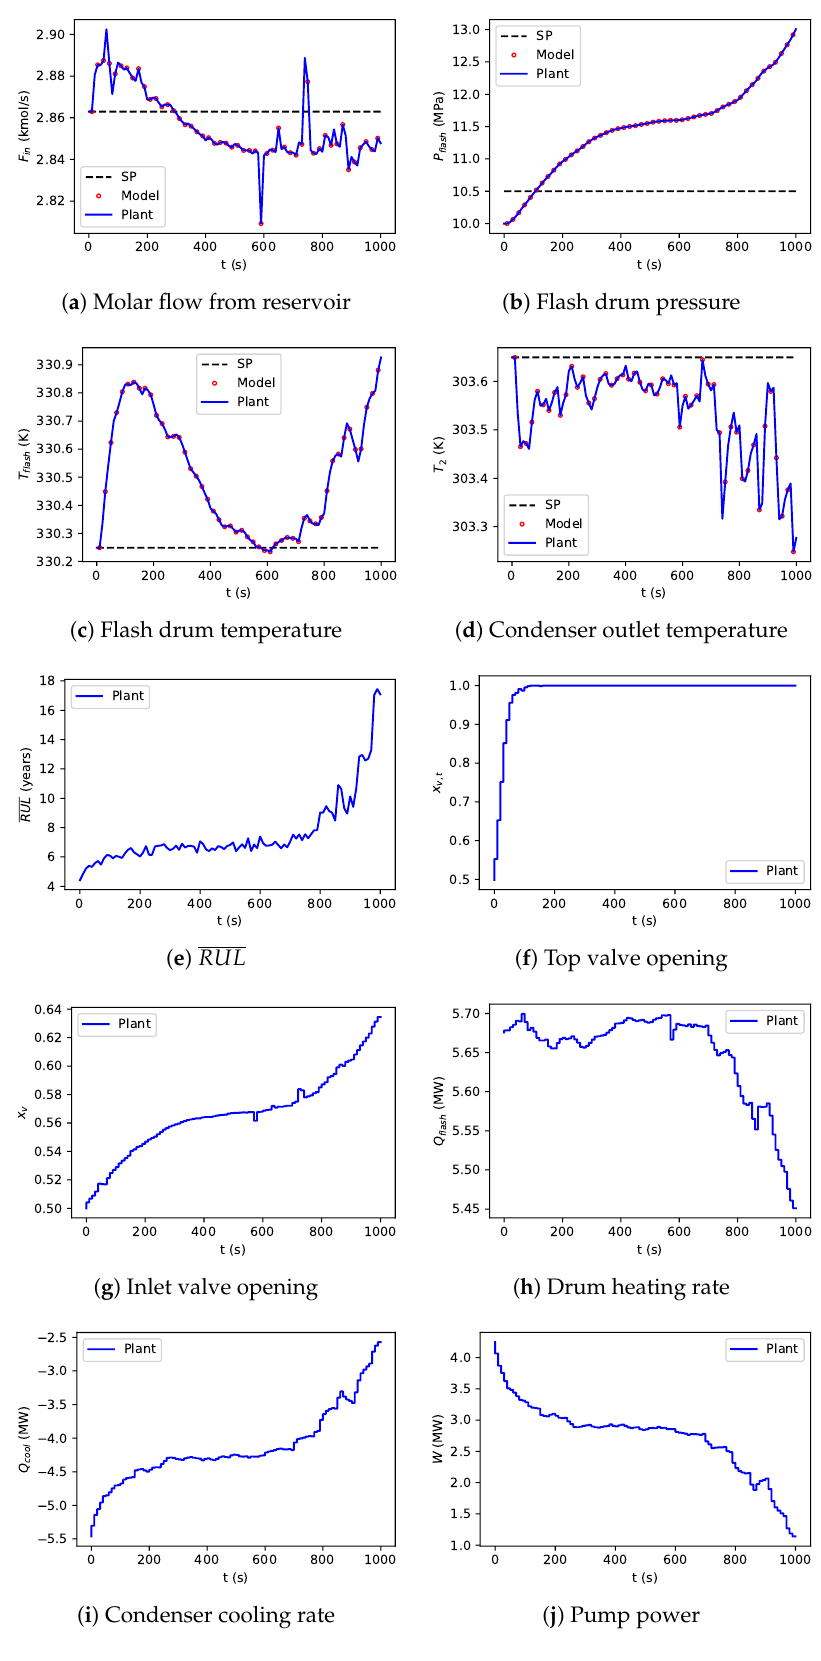
Figure 10. HAC simulation— w HAC = 100, N part =